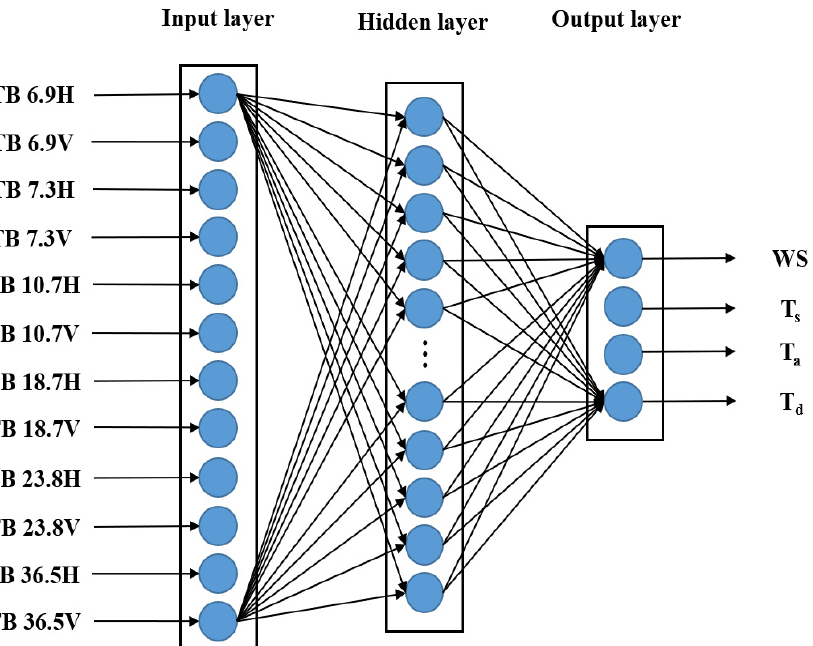
Figure 2. The topological configuration of the BPNN. H and V represent horizontal and vertical polarizations (e.g., TB 6.9H stands for horizontally polarized brightness temperature at 6.9 GHz). WS, T s , T a , and T d represent sea surface wind speed, sea surface temperature, near-surface air temperature, and dewpoint temperature, respectively.